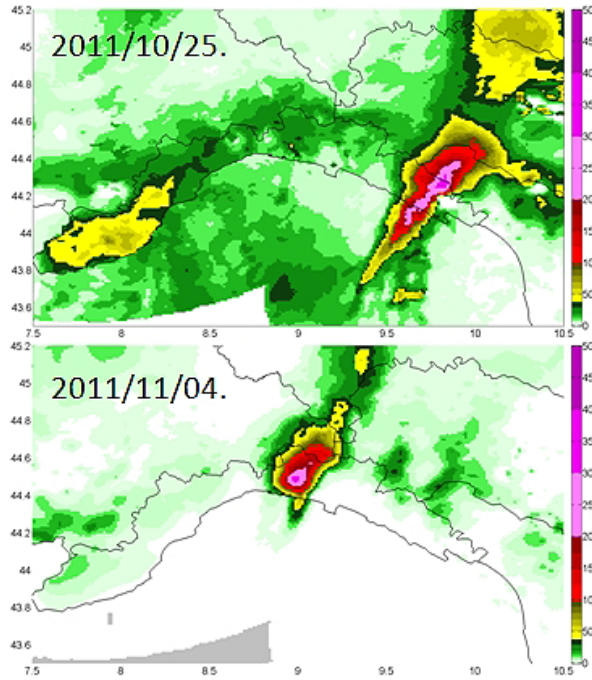
Figure 2. Comparison of the 6h maximum accumulated rain- fall (mm) for the events on 25 October 2011 (top panel) and on 4 November 2011 (bottom